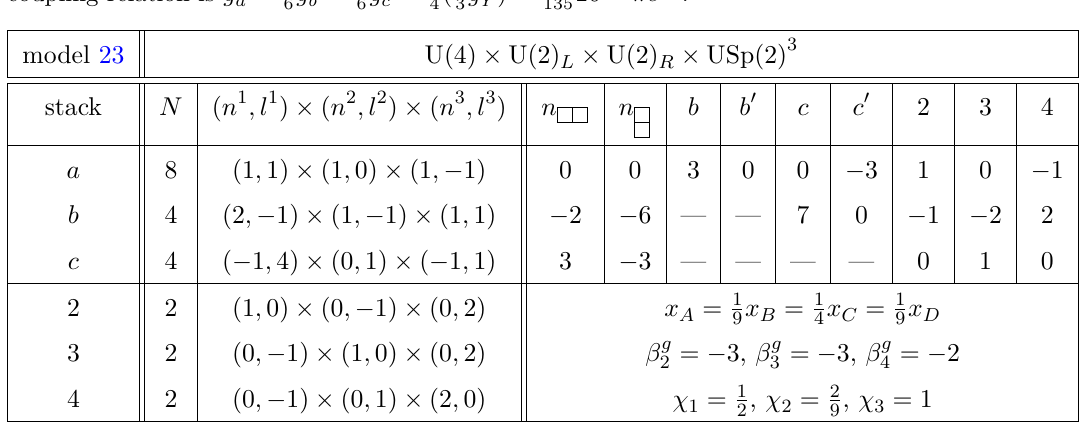
Table 23 . D6-brane configurations and intersection numbers of Model 23, and its MSSM